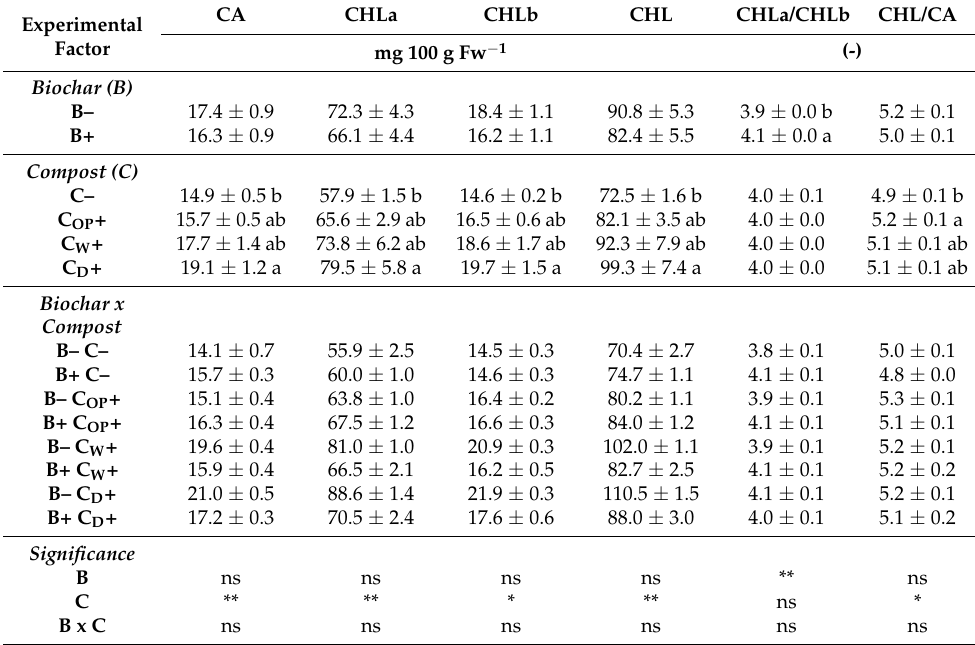
Table 4. Effect of biochar, compost, and biochar x compost interaction on carotenoids (CA), chloro- phyll a (CHLa), chlorophyll b (CHLb), total chlorophyll (CHL) leaf content, chlorophyll a to chloro- phyll b (CHLa/CHLb) and total chlorophyll to carotenoids (CHL/CA) ratios of Swiss chard. Experimental